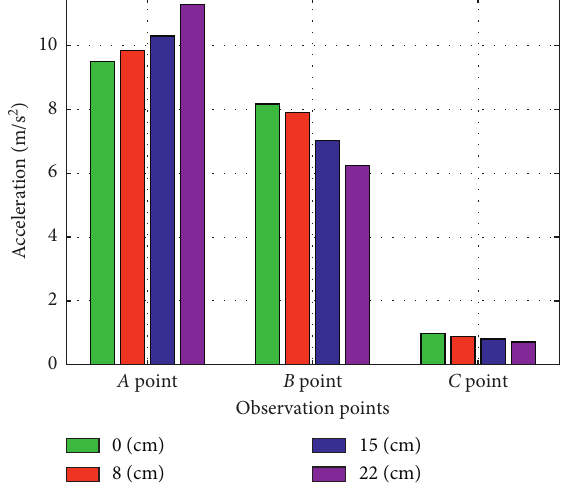
Figure 12: The amplitudes of the vertical accelerations at all the observation points versus various